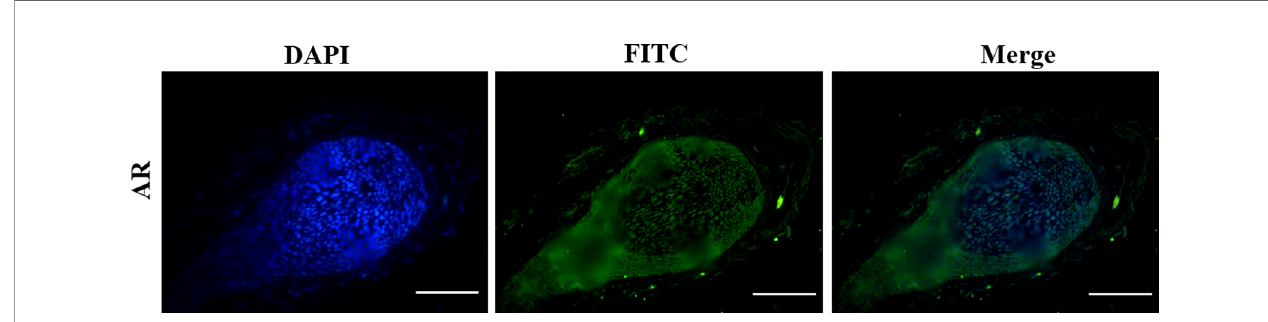
FIGURE 5 | The expression pattern of AR in the normal human hair follicles (HFs). AR is mainly expressed in dermal papilla cells and hair matrix cells. Scale bar 50 m